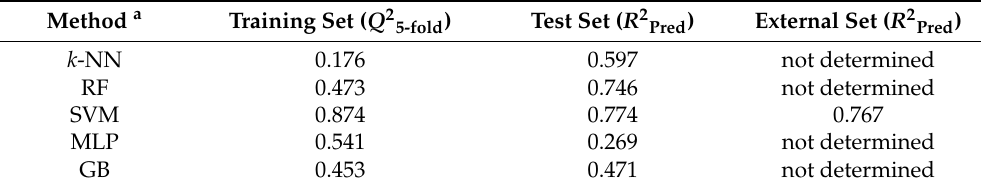
Table 5. Summary of the statistical parameters obtained from non-linear models based on different machine learning methods.